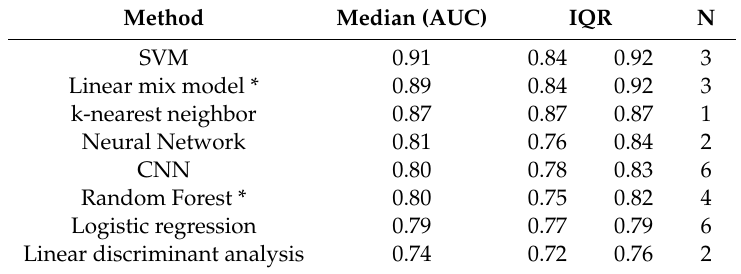
Table 1. Method performances in terms of the median area under the receiver operating curve (AUC) and respective interquartile range